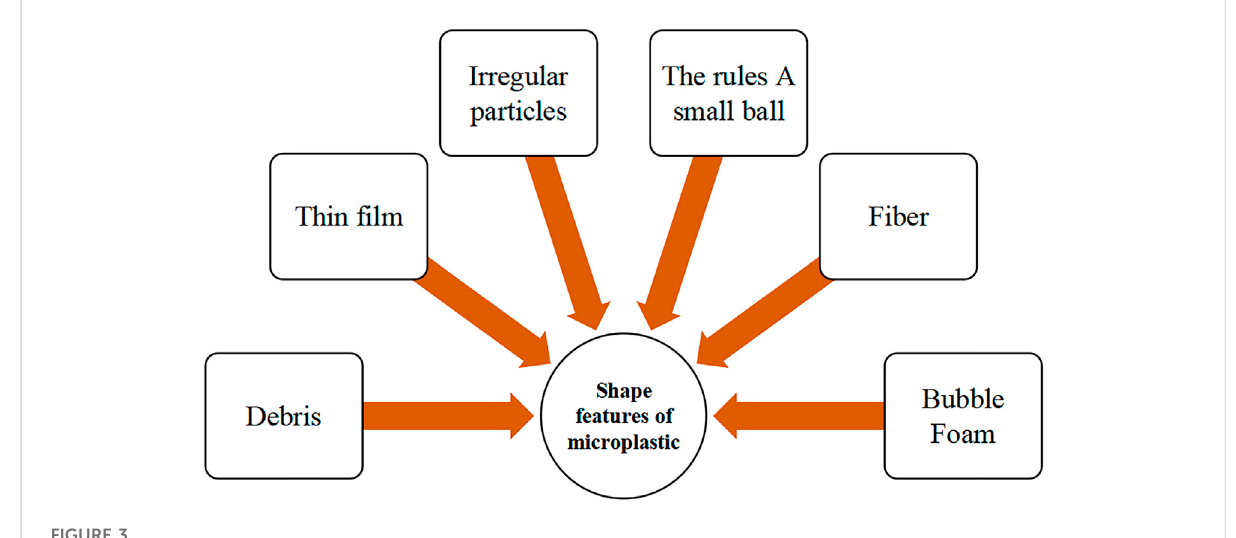
FIGURE 3 Classi fi cation diagram of microplastic shape